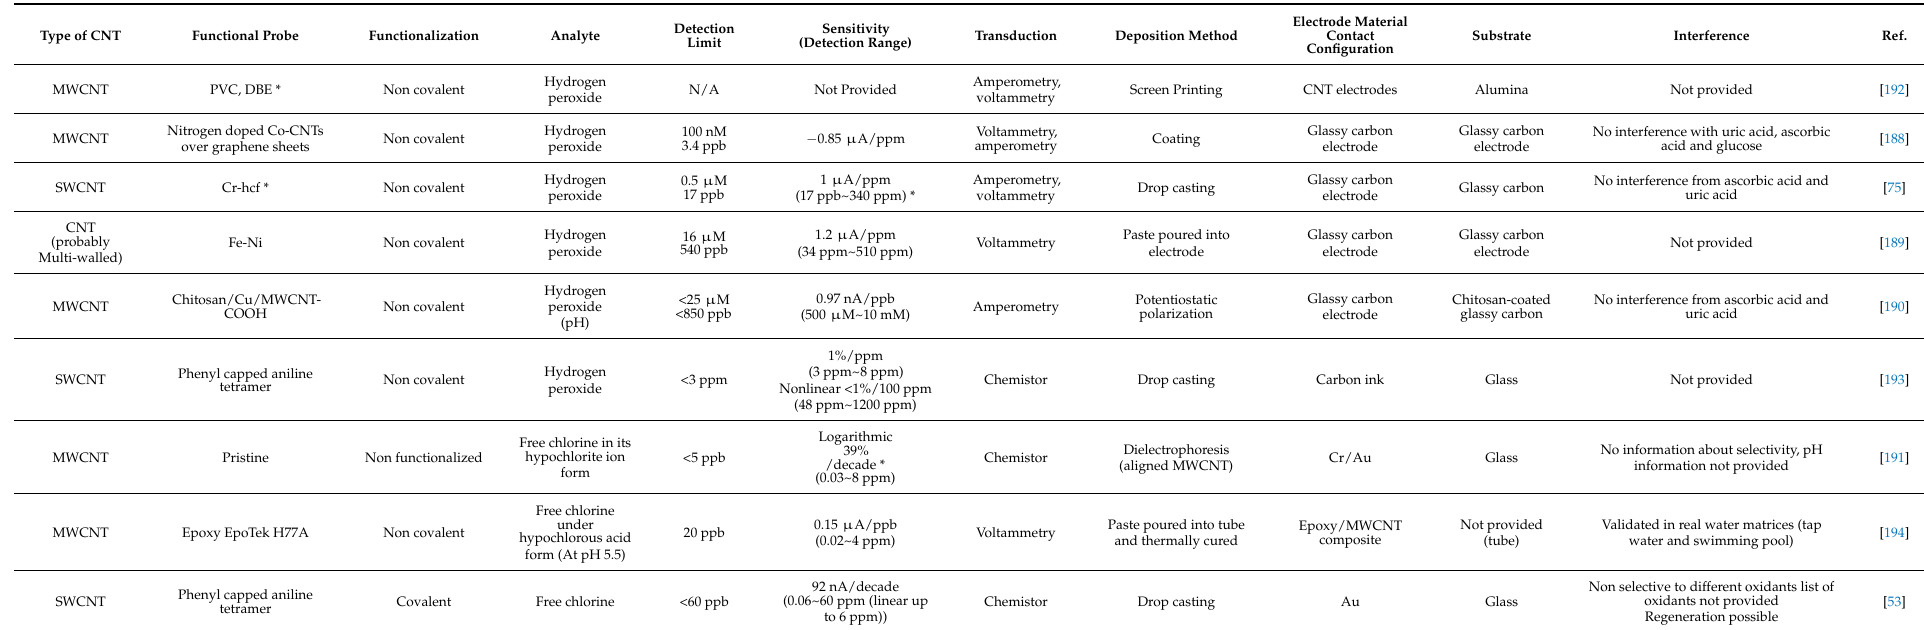
Table 14. CNT-based sensors for detecting disinfectants in water. References are sorted by type of analyte (hydrogen peroxide, free chlorine) then by limit of